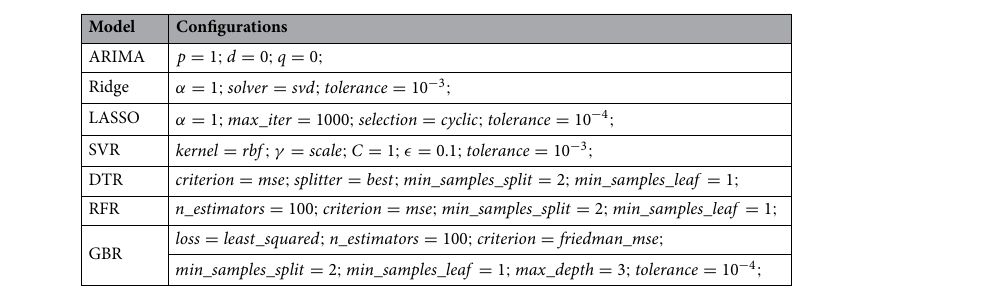
Table 2. Configurations of top-tier forecasting-specialized